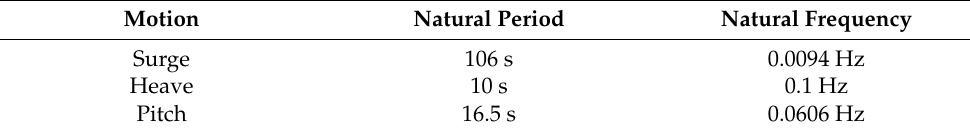
state, and the tension of the mooring line is small, so suspension #1 is selected to study the behavior of anchor chain tension at different environmental